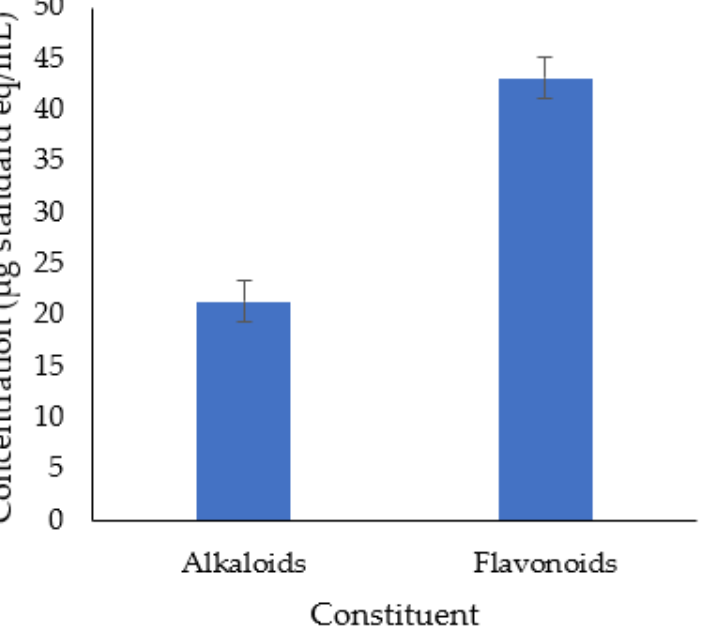
Figure 1. Alkaloids and flavonoids content in A. muricata leaf ethanol extract.